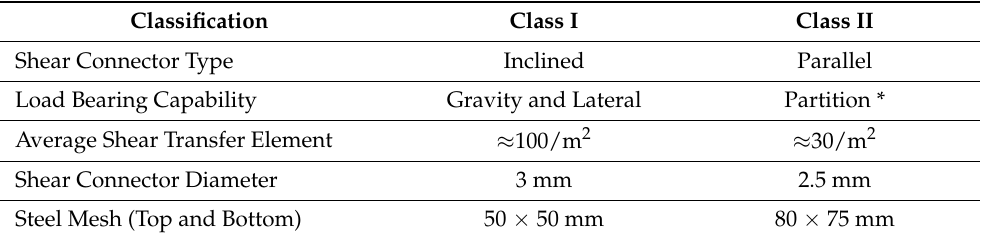
Table 1. Existing CSP Panel